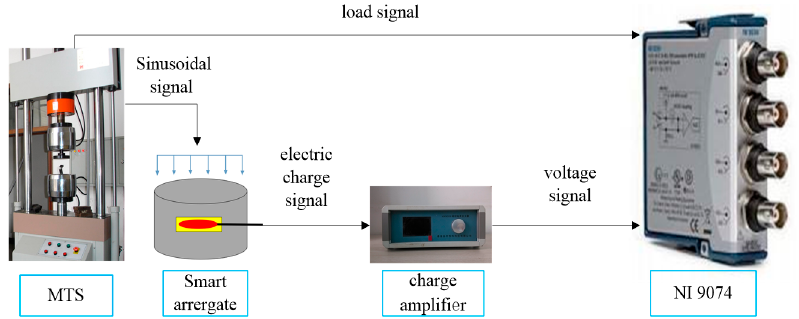
Figure 6. Calibration of smart aggregates.